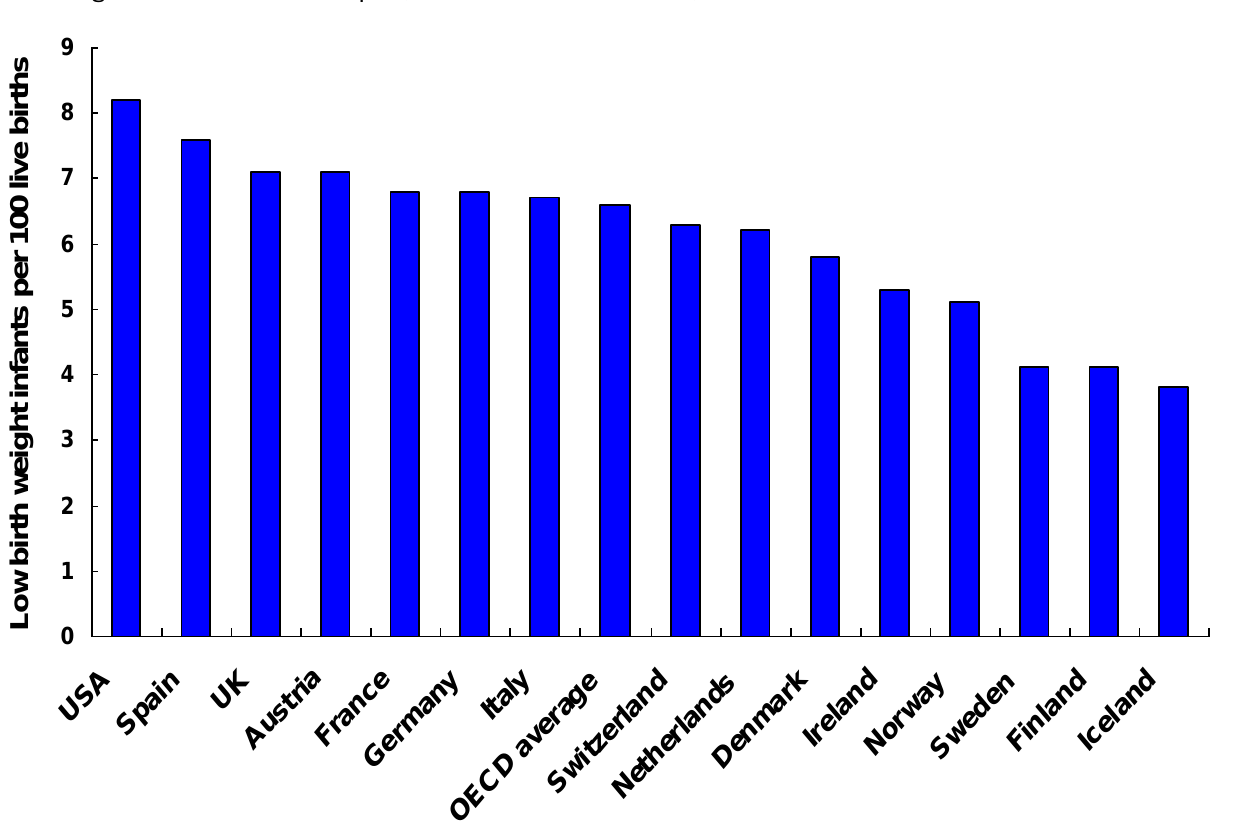
Figure 2. Infant low birth weight rates (number of low birth weight infants per 100 live births) in 2008 in selected OECD member countries. * Source : OECD Health Data 2011 (April 2011 version), World Bank 2011 (World Development Indicators), and WHO Regional Office for Europe (Health for All